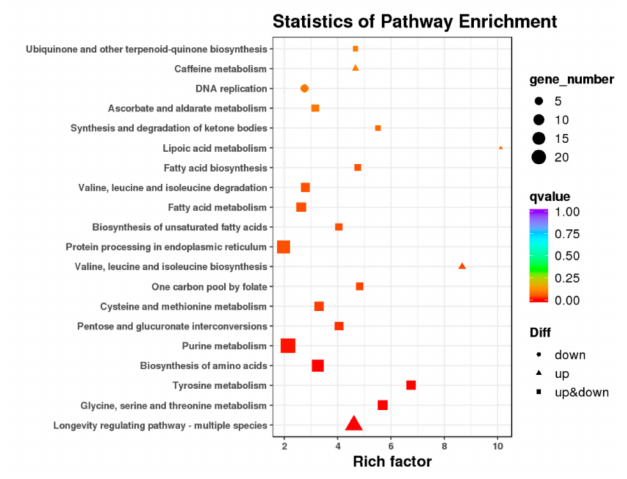
Figure 8. The KEGG enrichment pathways of differentially expressed